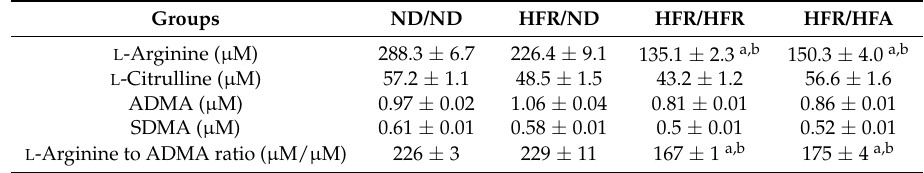
HFR/ND: maternal high-fructose intake; HFR/HFR: maternal high-fructose plus post-weaning high-fructose intake; HFR/HFA: maternal high-fructose plus post-weaning high-fat intake; ADMA: asymmetric dimethylarginine; SDMA: symmetric dimethylarginine; n = 8/group; a p < 0.05 vs. ND/ND; b p < 0.05 vs.